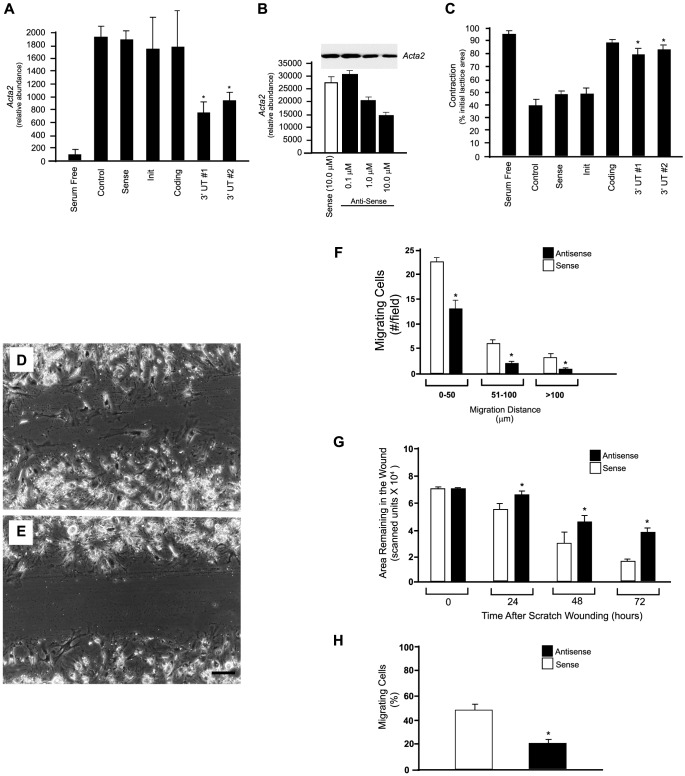

Acta2 antisense oligodeoxynucleotides inhibit Acta2 expression, stellate cell contractility, and stellate cell motility.Stellate cells were isolated from normal rat livers; after 24 hours, oligonucleotides were transfected as in Methods (the transfection mix containing oligonucleotides was replaced every 48 hours). Five days later, cells were harvested and lysates were subjected to immunoblotting to detect Acta2. In (A), different oligonucleotides (10 µM) were tested; specific Acta2 bands were scanned, quantitated and expressed graphically (n = 3, * p<0.01). In (B), the effect of different concentrations of sense and antisense oligonucleotides (the Acta2 3′UT #1 sequence) was examined. The upper portion of the figure depicts a representative immunoblot, and the graph below depicts scanned and quantitated data (n = 3, * p<0.01). Immunoblots with anti-cytoplasmic β-actin revealed no change in Acta2 expression (not shown). In (C), cells as above were placed on collagen lattices; oligonucleotides were added 24 hours later (all at 10 µM) and replaced at day 3 and 5 in culture. Serum free conditions were introduced and medium containing serum (10% horse/10% calf) was added to induce contraction. Lattices were dislodged from their plastic substrata and gel contraction was measured (contraction after 4 hours is shown, n = 4, *p<0.01 compared to lattices exposed to sense oligonucleotides). Cells exposed to only serum free or serum containing medium served as negative and positive controls, respectively. In (D–H), stellate cells from normal livers were isolated and allowed to undergo culture induced activation. Twenty-four hours after isolation, cells were transfected with oligodeoxynucleotides as in Methods. Seventy-two hours later, a linear scratch was applied to the cell monolayer. In (D), cells exposed to 3′UT #1 sense oligonucleotides (10 µM) are shown; in (E) cells exposed to 3′UT #1 antisense oligonucleotides (10 µM) are shown (representative images 24 hours after scratch wounding are shown) (bar = 50 microns). In (F), the number of cells per high-powered field entering the wounded area of the monolayer were counted and quantitated as in Methods (n = 6, *p<0.01 vs. cells exposed to sense oligonucleotides). In (G), the area in the wound remaining unoccupied by cells was quantitated by image analysis as in Methods (n = 6, *p<0.01 vs. cells exposed to sense oligonucleotides). In (H), the effect of Acta2 antisense oligodeoxynucleotides on stellate cell motility was assessed by measuring migration of stellate cells through polyethylene terphthalate membranes containing 8 µm pores as in Figure 2 (n = 3, *p<0.01 vs. to sense). Abbreviations: Init - initiation; UT – untranslated.